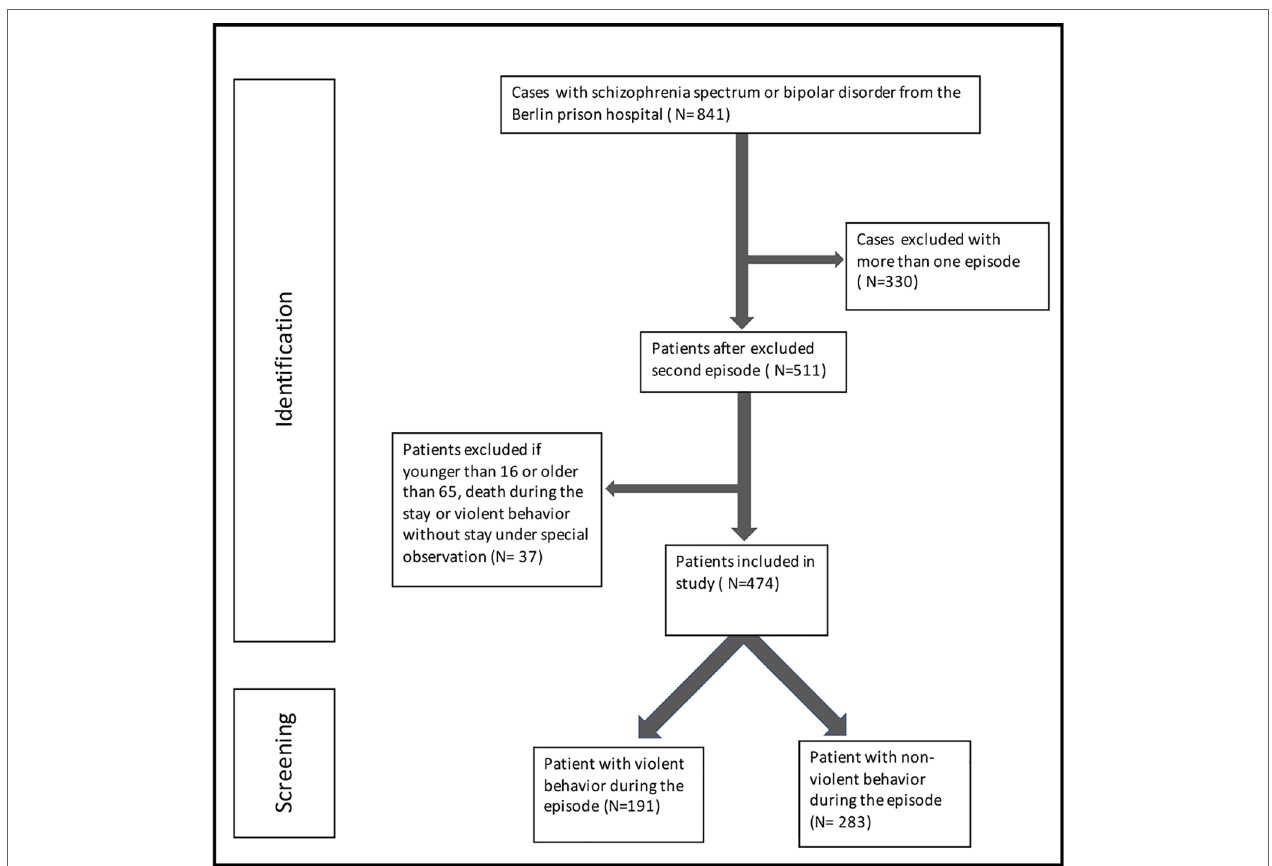
FIGURE 1 | Systematic identification for patients of the Berlin prison hospital from 1982 till